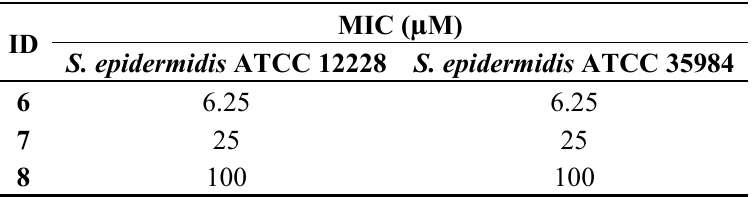
Table 2. Micromolar minimal inhibitory concentrations (MICs) of compounds 6 , 7 and 8 .